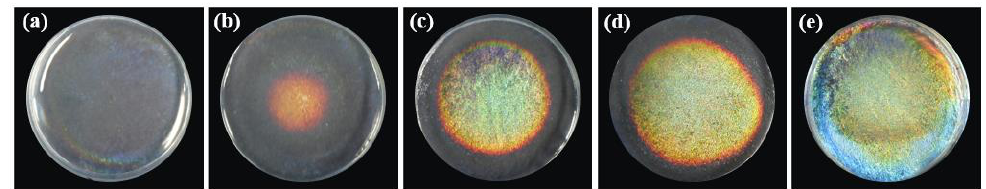
Figure 2. Photos of CNC film formation process: ( a ) 0 h; ( b ) 48 h; ( c ) 49 h; ( d ) 50 h; ( e ) 51 h (d = 3.5 cm).